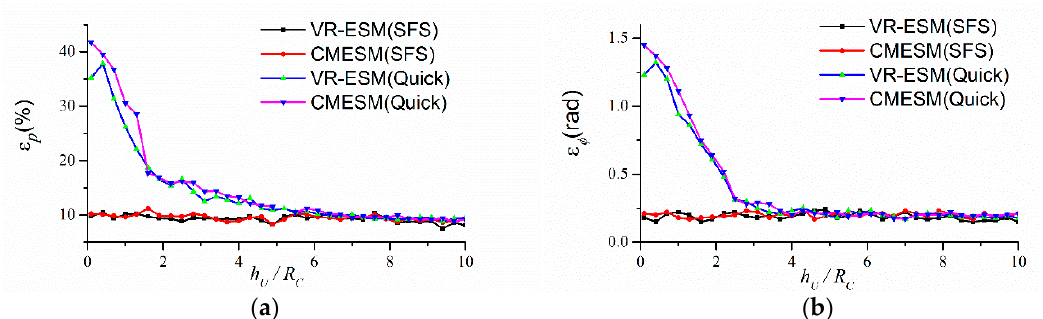
Figure 19. Prediction errors at different submerged depths in the SFS case and Quick case when 90 measurement points are used ( h U = 0.2 m, f 0 = 300 Hz ). ( a ) ε p and ( b ) ε Φ .